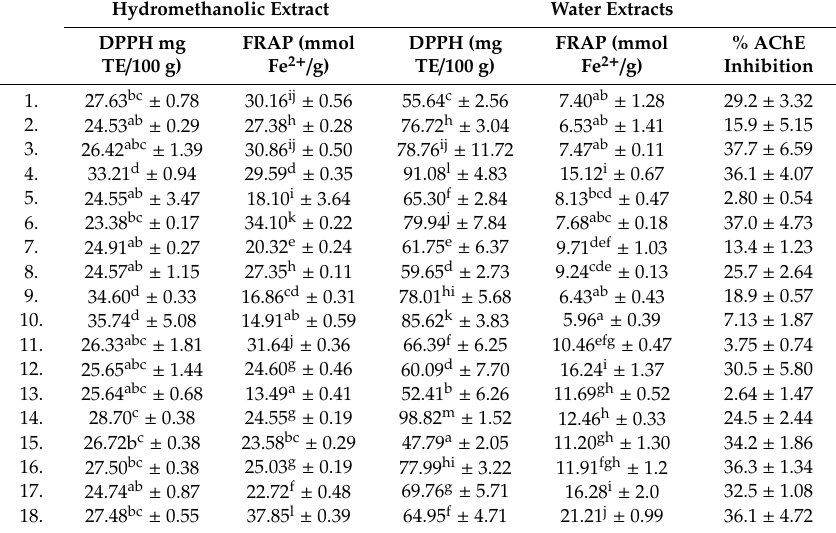
Table 4. Antioxidant activity and acetylcholinesterase (AChE) inhibitory activity of Morus alba L.